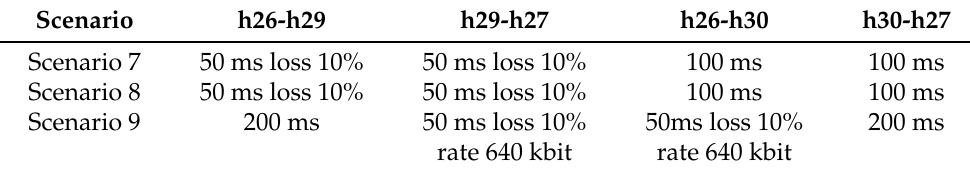
Table 2. Delay and packet loss configurations tested with Topology